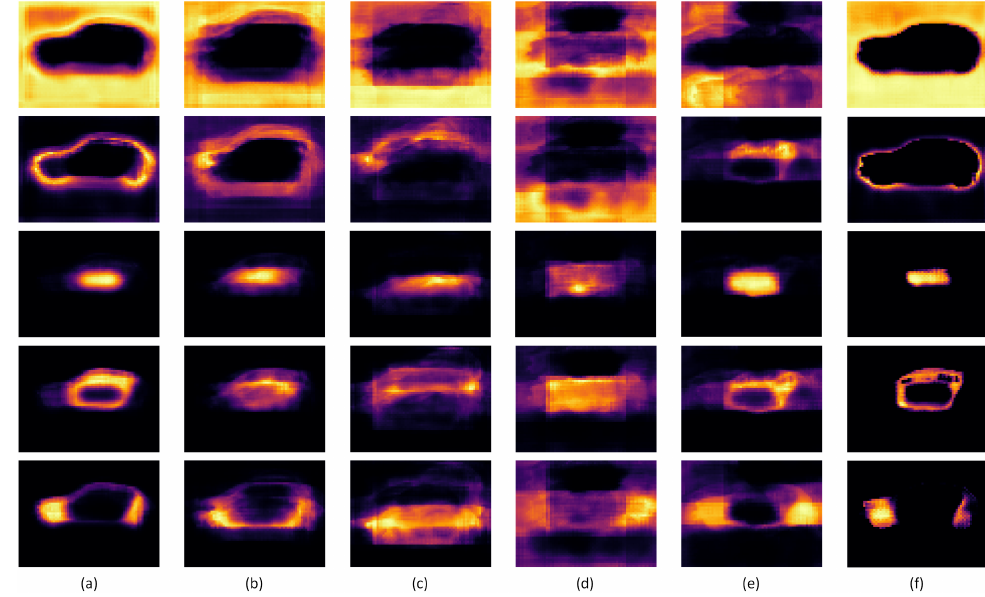
Figure 9. Converged responsibility maps collected from EMA units from different levels. ( a ) Maps from DA-EMA block 1. ( b ) Maps from DA-EMA block 2. ( c ) Maps from DA-EMA block 3. ( d ) Maps from DA-EMA block 4. ( e ) Maps from DA-EMA block 5. ( f ) Maps from output EMA